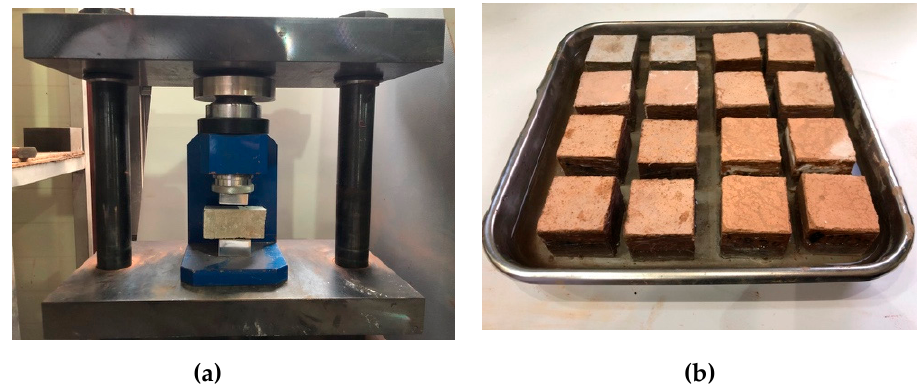
Figure 5. Test setup of ( a ) compressive strength and ( b ) water absorption.